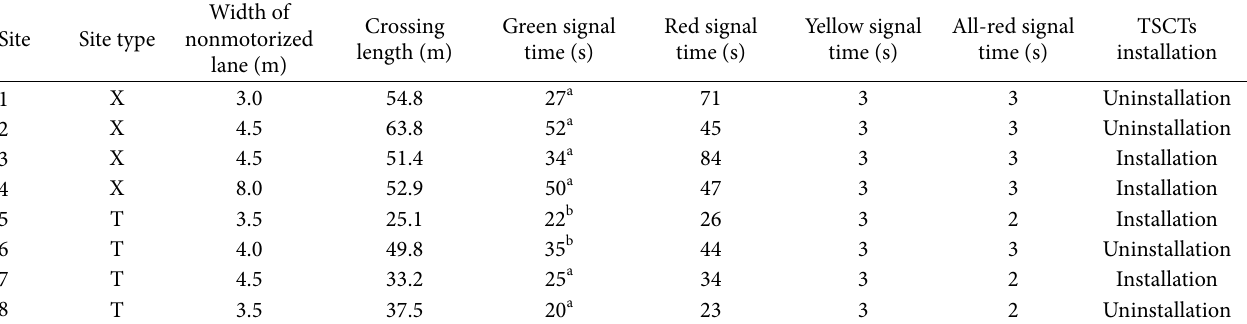
Table 2: Descriptions of the selected signalized intersections.